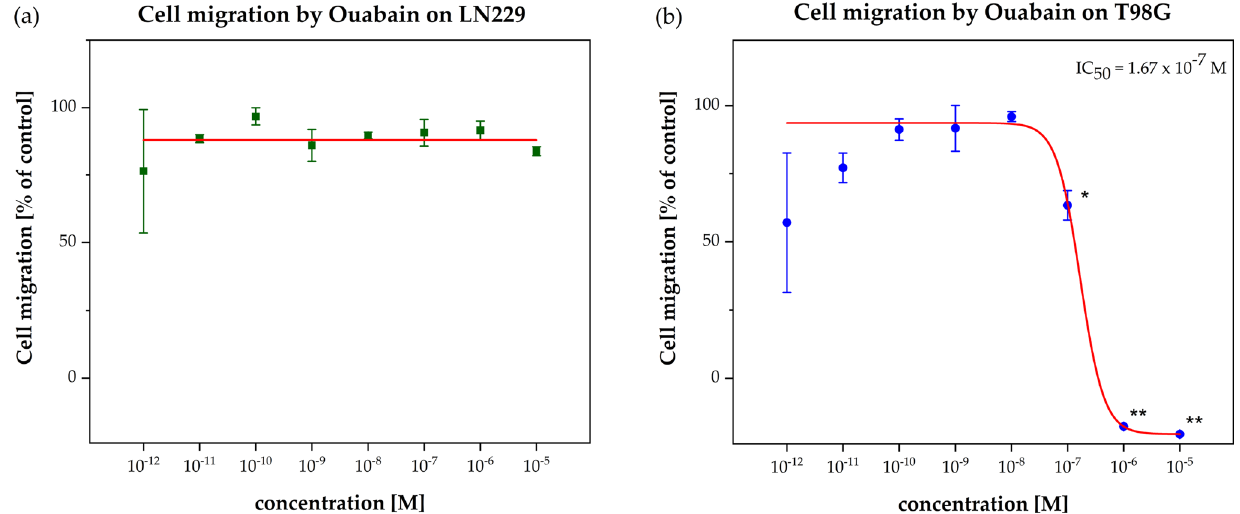
Fig. 1 Cell migration assay with cell line LN229 ( a ) and T98G ( b ). The cell migration (% of control) was plotted as the function of the Ouabain concentration (10 –12 to 10 –5 M). The red curves represent the nonlinear regression analysis for the IC migration was only observed for the TMZ-resistant cell line T98G by IC each duplicate and the level of significance is shown by the p-value range ( * p < 0.05 and ** p < 0.01)